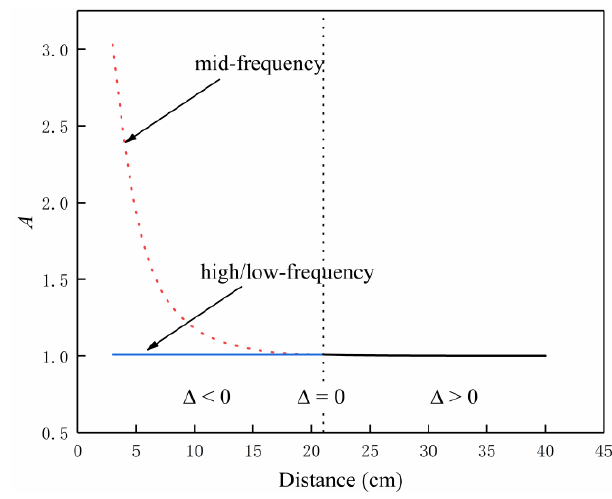
Figure 6. Amplification factor for different frequency branches versus the distance between the Tx and Rx coils at complete matching. Energies 2020 , 13 , x FOR PEER REVIEW